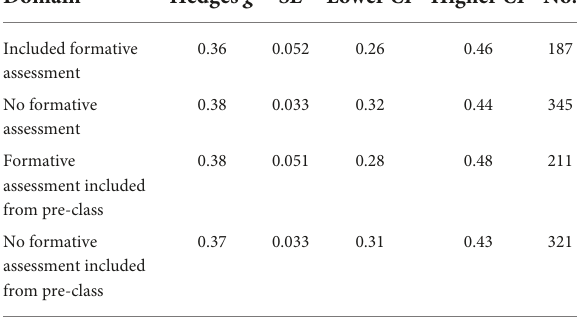
TABLE 7 Hedges g effect-size moderated by the role of formative assessment.